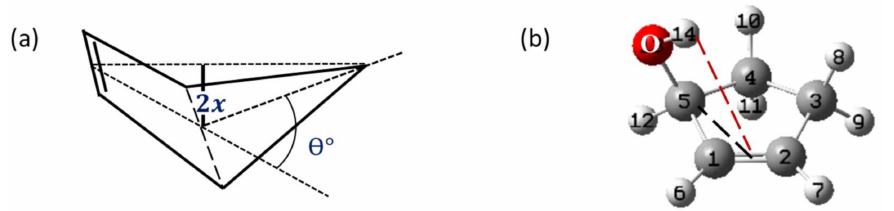
Figure 7. ( a ) Definition of the ring-puckering coordinate (x), where 2x is the distance between the two dotted lines and Ө is the ring puckering angle. ( b ) 2-cyclopenten-1-ol